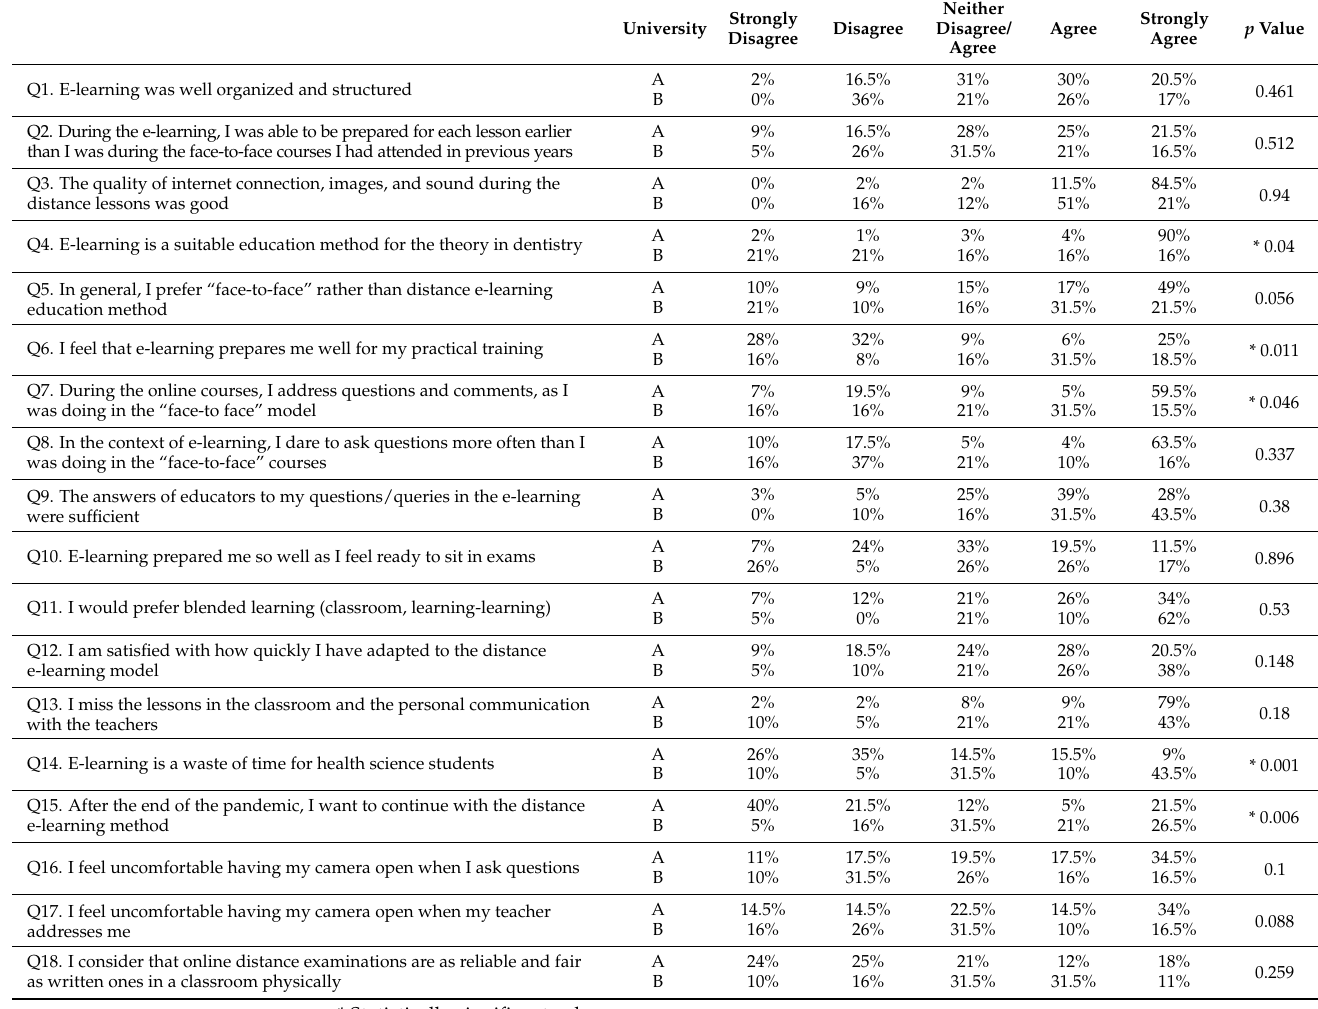
Table 3. Results for the questions concerning distance e-learning education of third-year students in Dental School B (Copenhagen University) and comparison with the corresponding answers achieved by third-year students in Dental School A (Athens University). Neither University Strongly Disagree Disagree Disagree/ Agree Strongly Agree p Agree